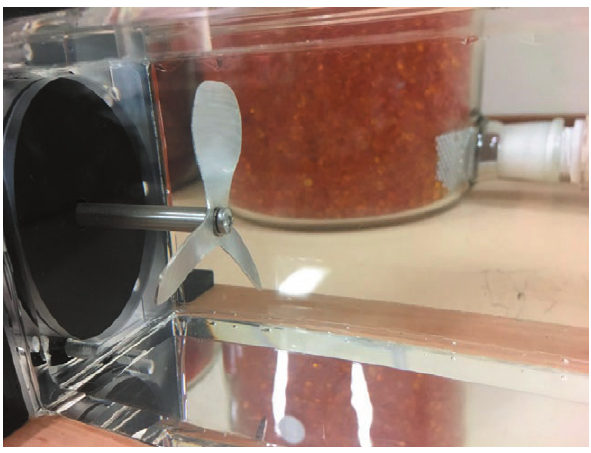
Figure 7. Cavitation occurring in air-equilibrated water at atmos- pheric pressure at a propeller rotation rate of 2960 rpm.